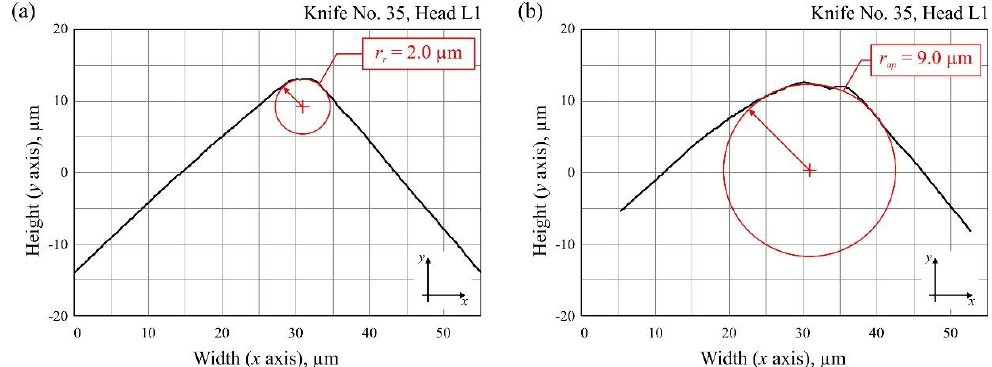
Figure 4. Method for determining the radius of the cutting edge of the industrial planer knives: ( a ) No. 35 (reference) (Set 1, Head L1); ( b ) No. 35 (after processing) (Set 1, Head L1).